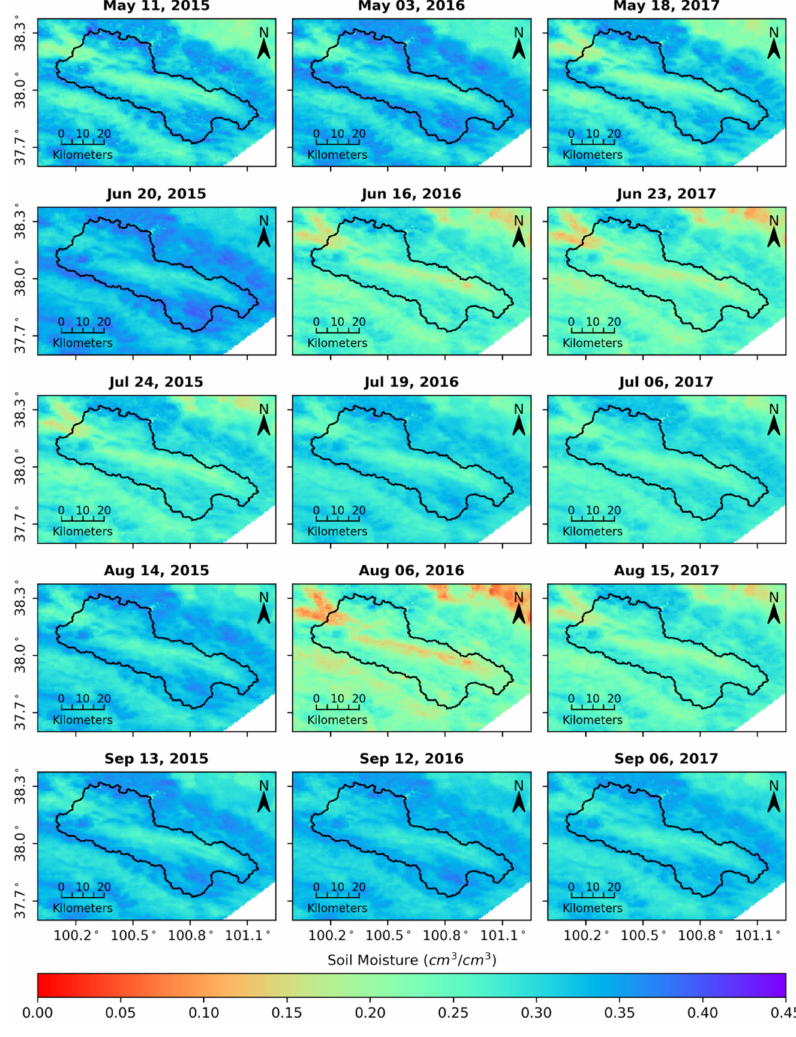
Figure 6. Daily upscaled results at the 1 km scale.